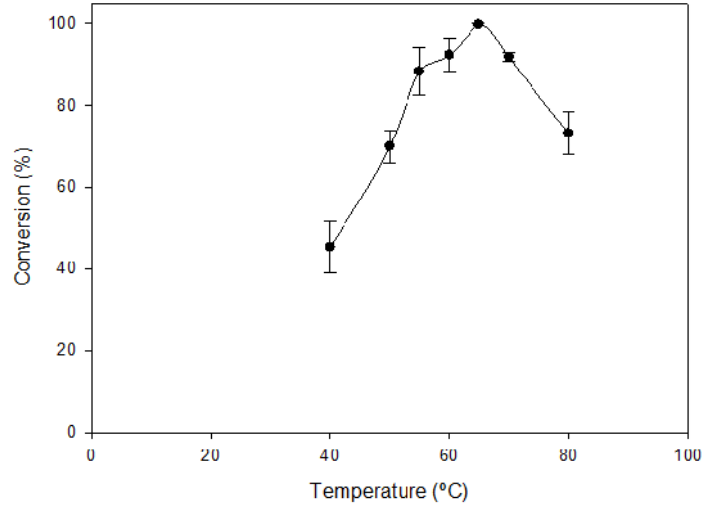
Figure 3. Optimal reaction temperature of the system using 10 mM D , L ‐ methylthioethylhydantoin as substrate, 100 mM borate buffer pH 8 supplemented with 1 mM CoCl 2 , for 4 h at 50–70 °C with constant stirring. Compounds of the multi ‐ step reaction were separated in HPLC water with a Zorbax C 18 column, mobile phase of 80:20 20 mM phosphoric acid, pH 3.2, and methanol, 0.4 mL/min, and measurement at λ = 203 nm.